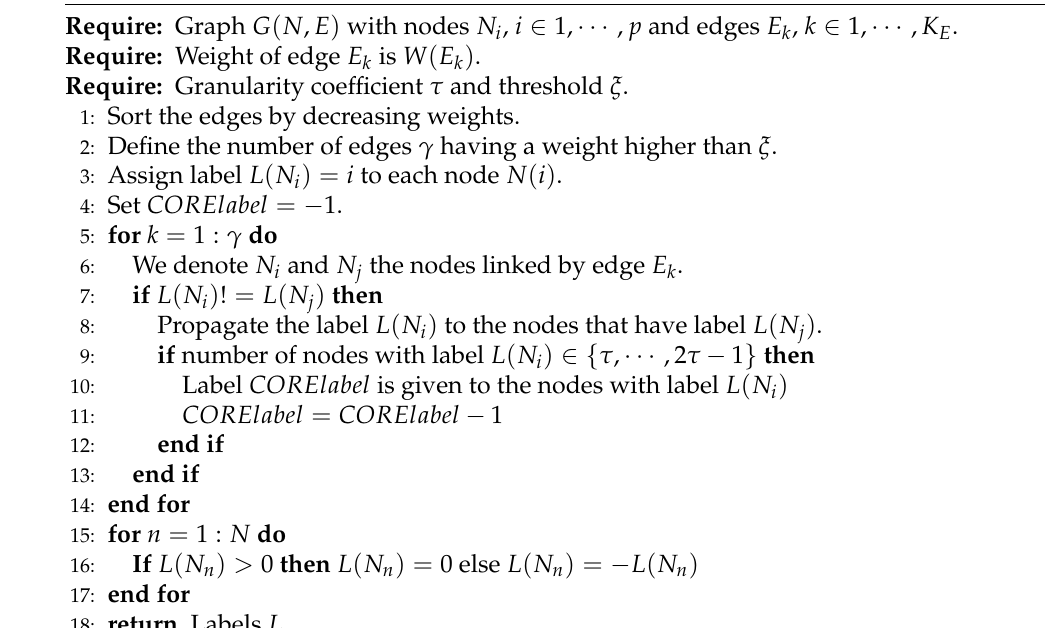
Algorithm 3 Greedy CORE-clustering